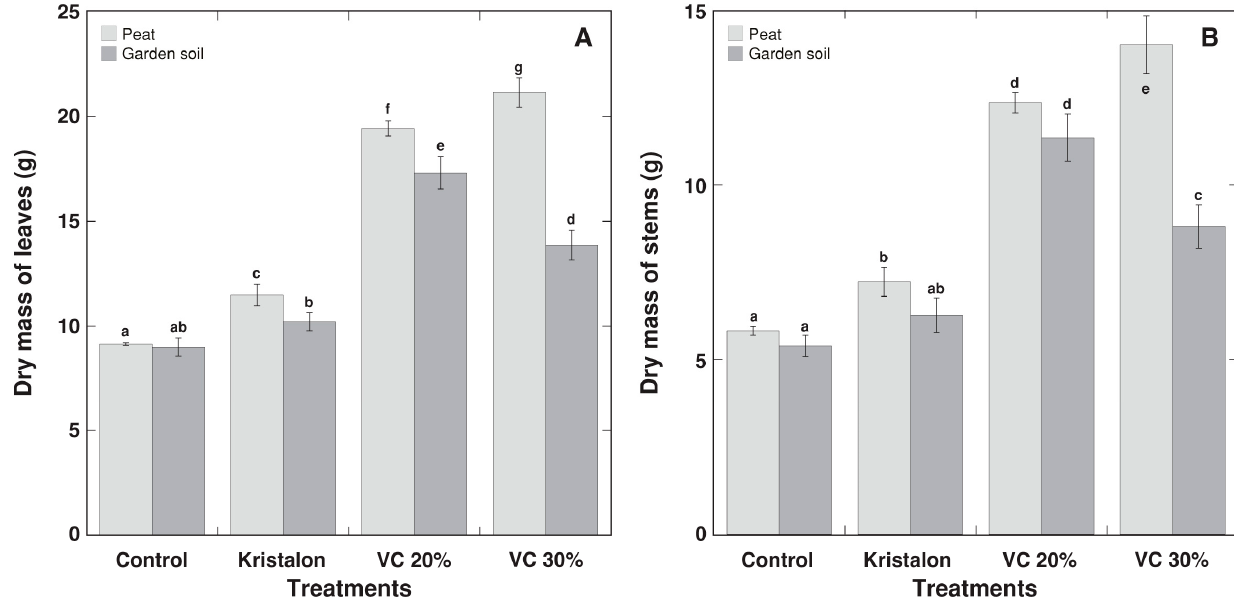
Figure 5. Effect of mineral fertilizer (Kristalon) and amendment with vermicompost (VC) at a 20% and 30% ( v / v ) rate on dry mass of leaves ( A ) and stems with inflorescences ( B ) of Dracocephalum moldavica plants grown in peat substrate or commercial garden soil for 8 weeks. Results are means ± SE from five replicates for each treatment. Means with identical letters are not considered statistically significantly different ( p < 0.05).